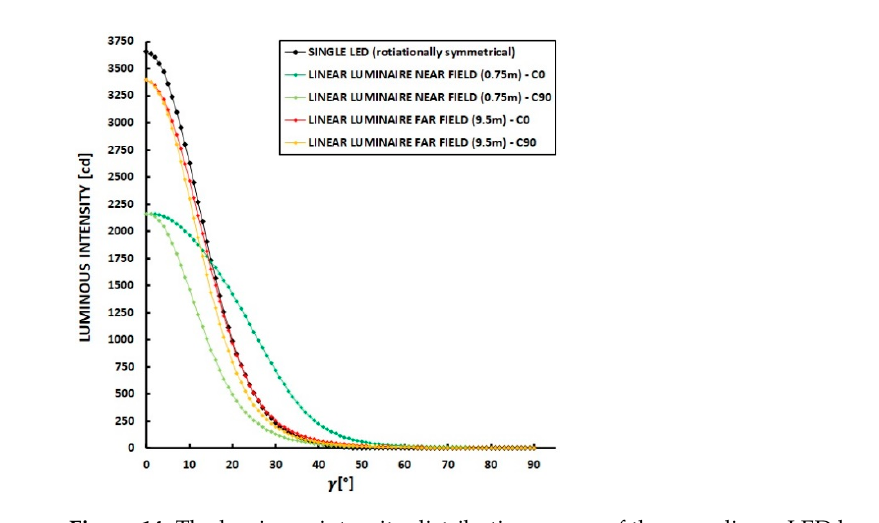
Figure 14. The luminous intensity distribution curves of the same linear LED luminaire used in the previous simulations (Figures 8 and 9), measured at different distances from the luminaire and for a single LED applied in this luminaire. The curves are scaled for the light source with a luminous flux of 1000